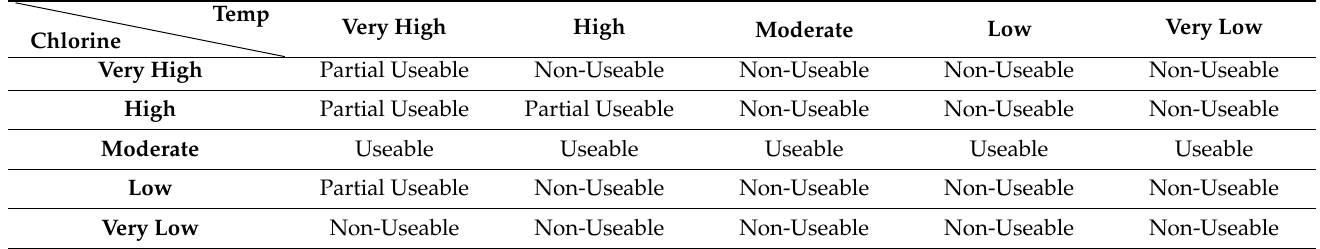
Table 2. Fuzzy Associative Mapping for water quality